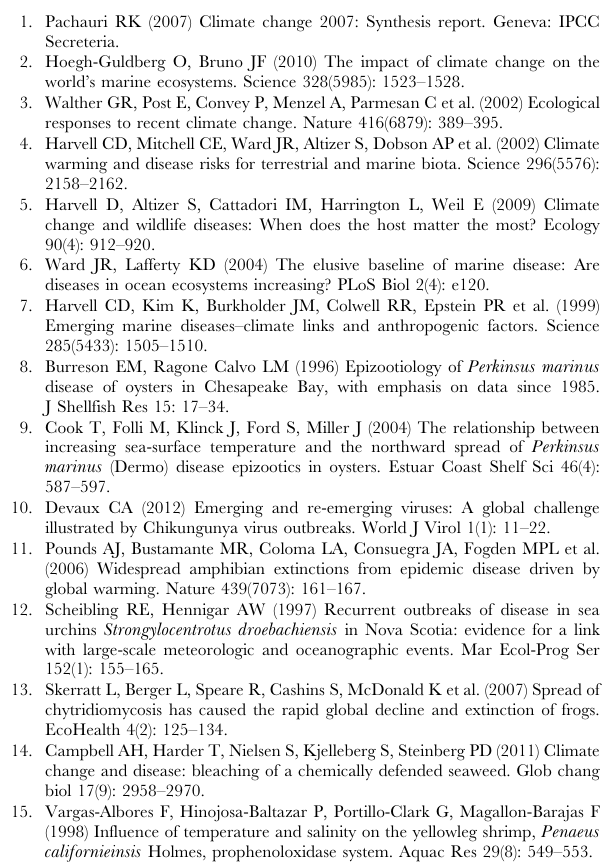
Table S1 Detailed results of the GO term enrichment analysis for the up-regulated set of genes. Table S2 Detailed results of the GO term enrichment analysis for the up-regulated set of genes. Table S3 Candidate innate immune genes, Annotation, Contig name, Sequence, Primer, BlastX results and protein domain. Table S4 Expression of innate immune candidate genes, numerical